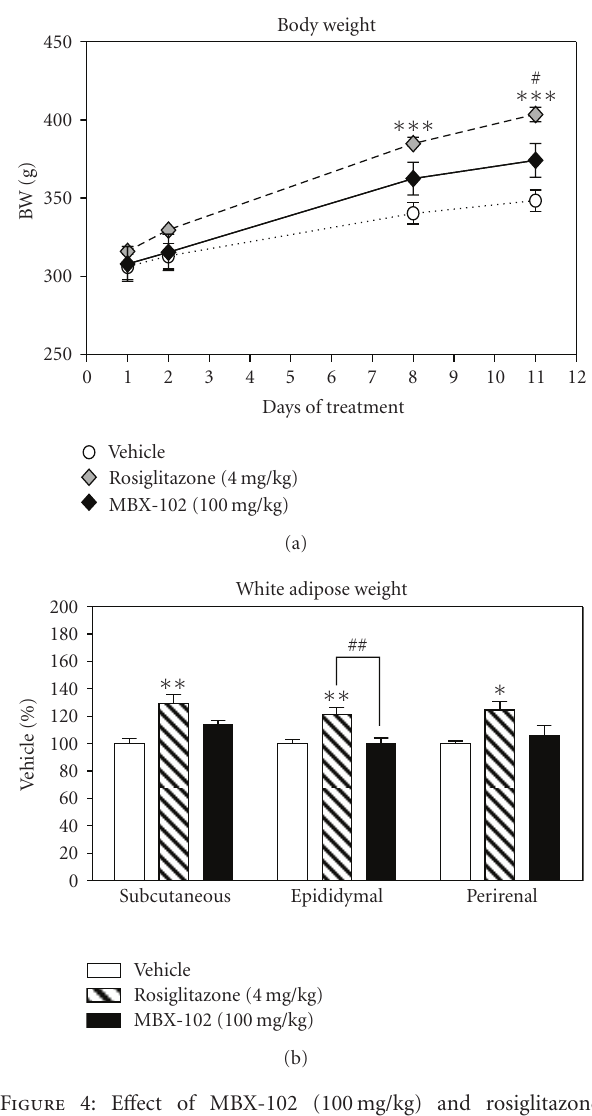
Figure 4: E ff ect of MBX-102 (100mg/kg) and rosiglitazone (4mg/kg) on body weight (BW) (a) and white adipose tissue weights (b) after 11 days of treatment of male ZDF rats. For the adipose tissue weight, the values are plotted as mean percentage of vehicle ± SEM ( ∗ : P < . 05, ∗∗ : P < . 01, ∗∗∗ : P < . 001 versus ZDF Vehicle; #: P < . 05, ##: P < . 01 versus MBX-102, (a) 2-way ANOVA and Bonferroni post tests or (b) 1-way ANOVA and Tukey’s multiple comparison